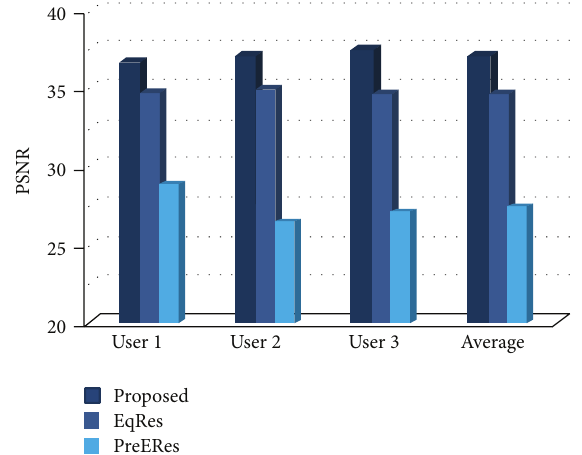
Figure 2: Comparison of the performance of different frameworks.